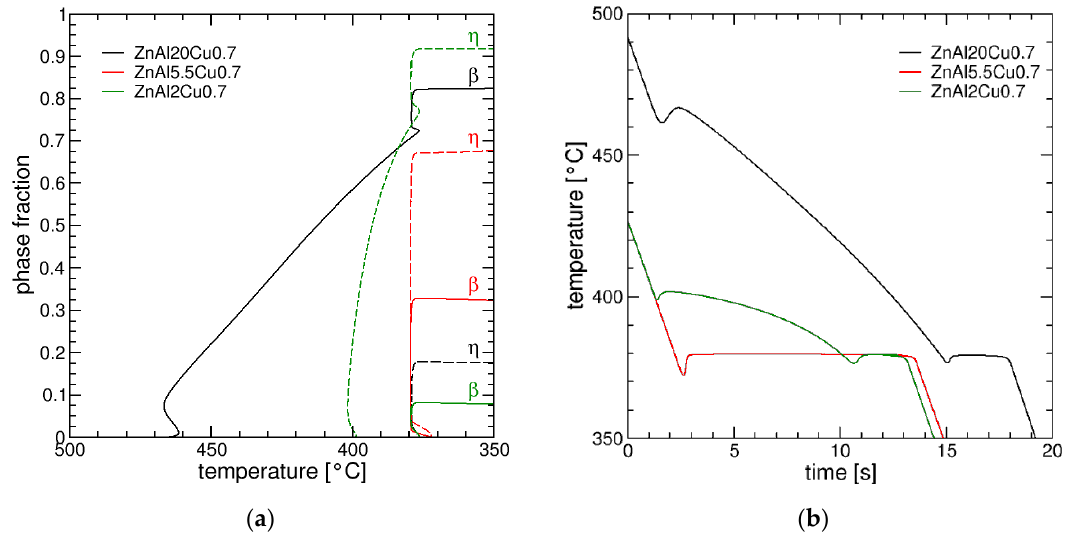
Figure 3. ( a ) Phase fractions versus temperature for three alloys with different Al compositions (β denotes the fcc-phase, η the hcp-Zn phase). ( b ) Temperature versus time for the three alloys as derived from the simulations.